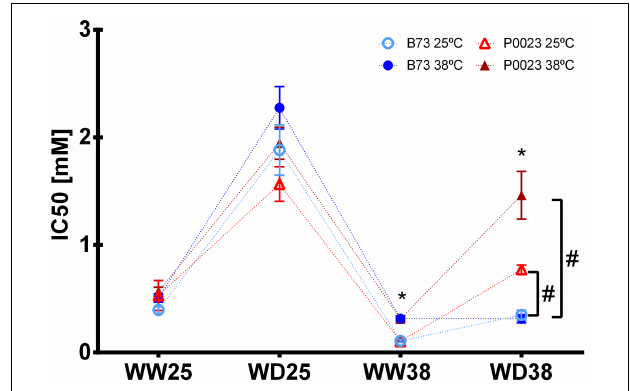
FIGURE 5 | Sensitivity of PEPC activity to the inhibitor L-malate in two maize genotypes (B73, P0023) grown under WW and WD conditions and acclimatized to 25 or 38 ◦ C. The IC50 was measured at 25 ◦ C (open symbols) and 38 ◦ C (closed symbols) in extracts of fully expanded leaves from 4-week-old maize plants. Asterisks denote statistically significant differences between experimental temperature in the same genotypes and condition ( t -test, p < 0.05), and hash between two genotypes in the same condition and experimental temperature ( t -test, p < 0.05), n = 4–5 biological replicates.